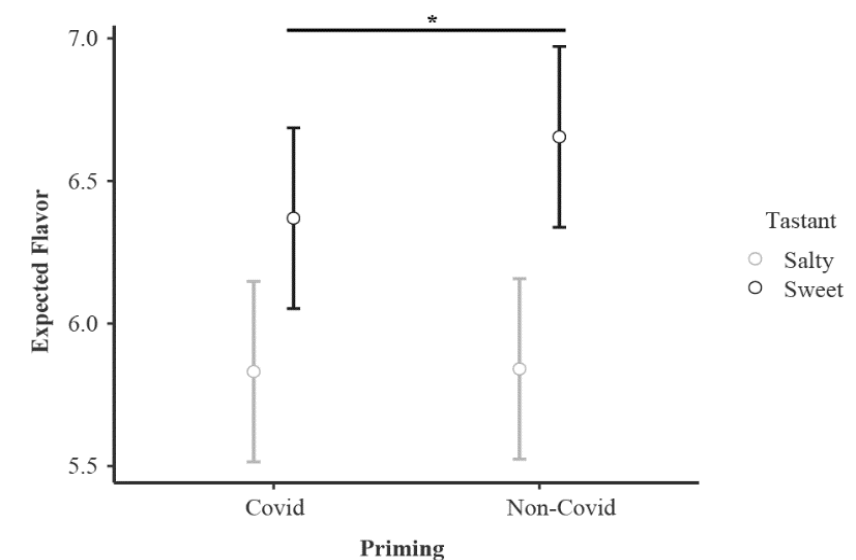
Figure 4. Priming effect observed for sweet food (vs. salty) in flavor expectation. Interaction effect between Priming video and Tastant is depicted. Graph depicts the mean value for flavor expectation. Bars indicate confidence intervals (95%). * p < 0.05.